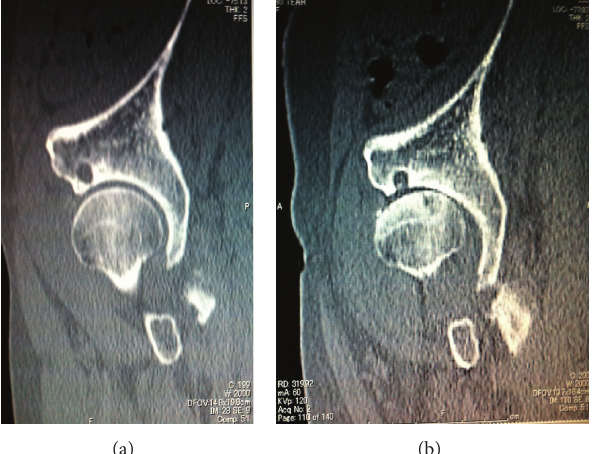
Figure2:SagittalplaneofCT.BeforerightTHA,enoughjointspacewiththebonecystatanteriorpartoftheacetabulum(a).BeforeLeftTHA, narrowing joint space with destruction of the bone cyst at anterior part of the acetabulum. Femoral head is also flattened with subchondral sclerotic changes due to osteoarthritis development